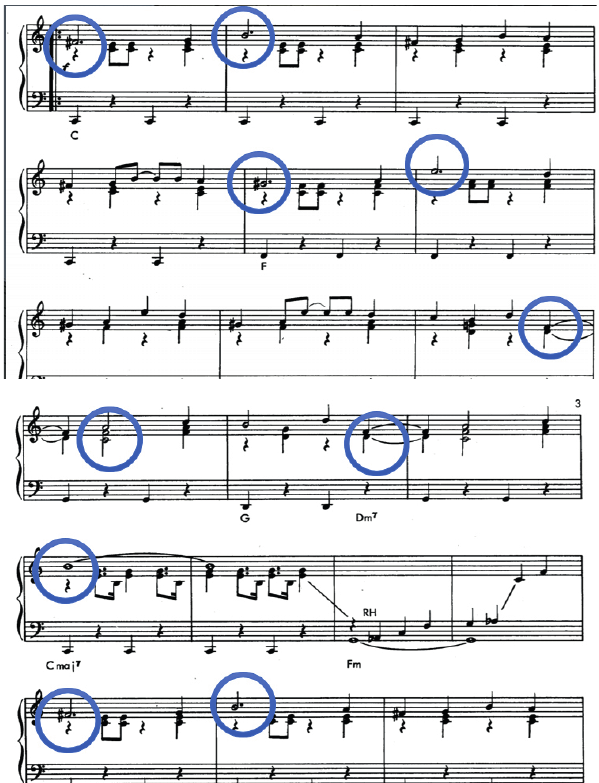
Figure 3. The “adorable scoundrel” notes in the section A of the theme (source: created by the